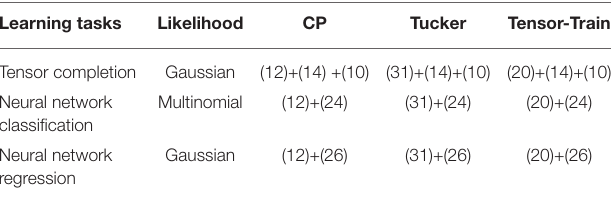
TABLE 1 | Equations to calculate the potential energy U ( 2 ) for different tensor learning tasks and with different low-rank tensor formats. Learning tasks